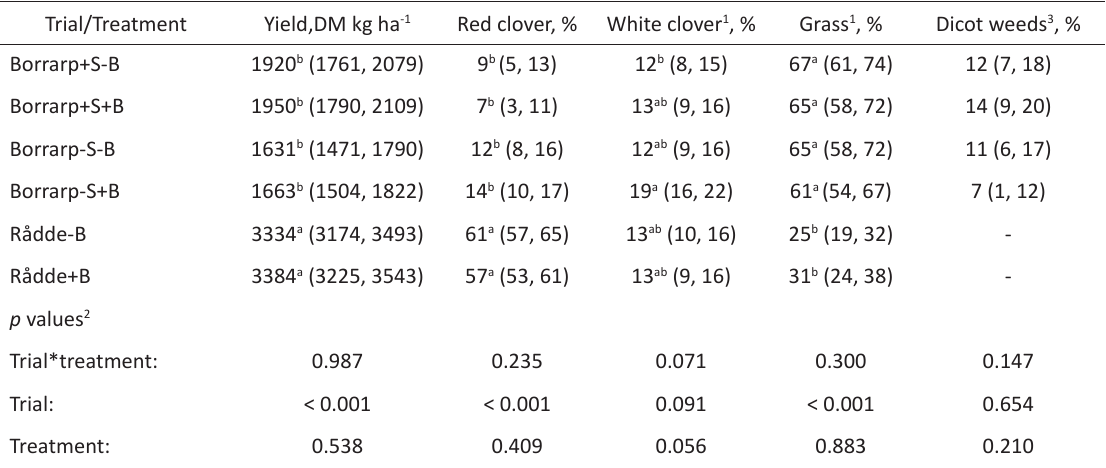
Table 1. Biomass yield (DM kg ha -1 ) and botanical composition (DM basis) of the ley crop. The LSMEANS are given, with the upper and lower values within brackets. Significant differences ( p < 0.05) between treatments are indicated by different superscripts within